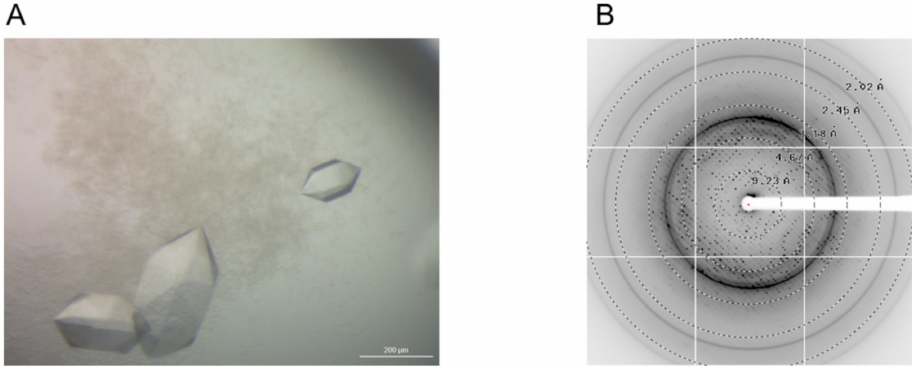
Figure 4. Crystal and preliminary X-ray diffraction analysis of LjSSB. ( A ) The LjSSB crystal obtained under 0.1 M of phosphate-citrate pH 4.2 and 1.6 M of NaH 2 PO 4 /0.4 M K2HPO 4 . ( B ) The diffraction image of LjSSB crystal. The diffraction spots are indicated at a resolution of 2.6